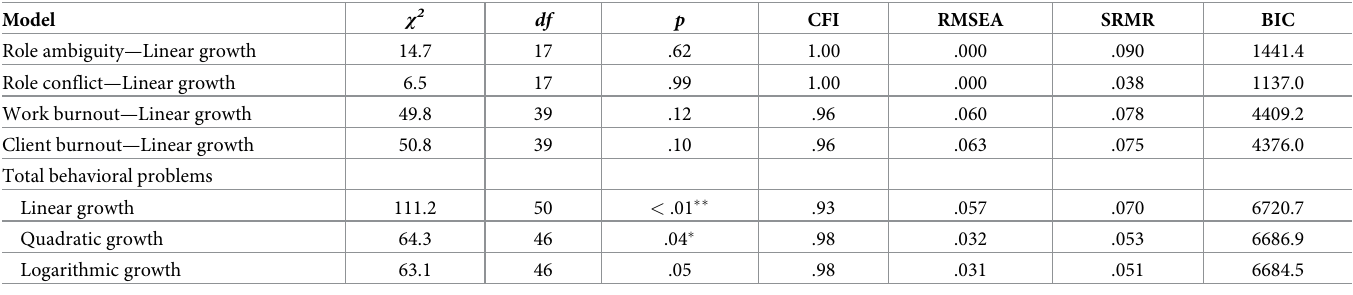
Table 2. Model fit indices of the latent growth models for the study variables. Model χ